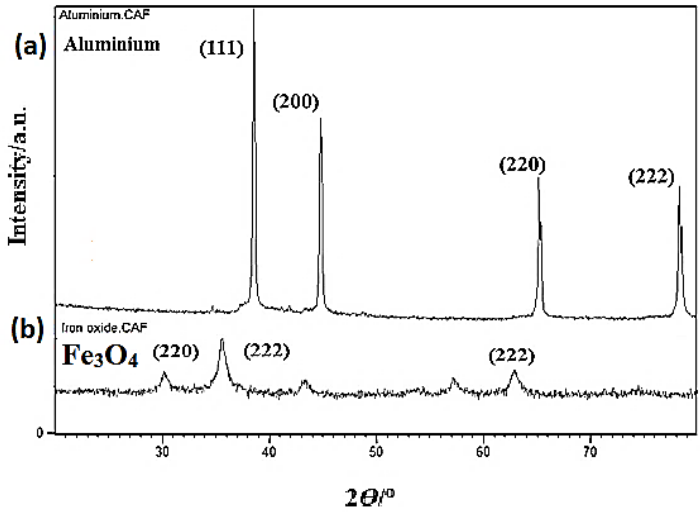
Figure 7. XRD analysis for ( a ) pure aluminium and ( b ) magnetite.